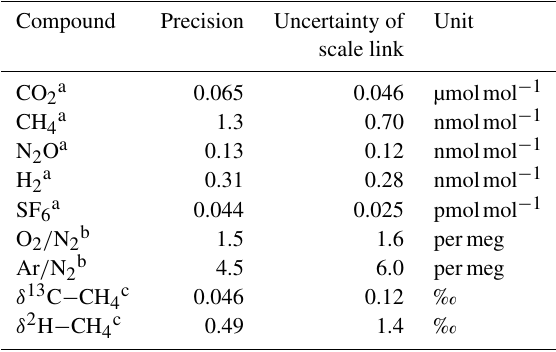
Table 1. Average measurement uncertainties of the flasks collected during CoMet 1.0. All values given with coverage probability of 0.68. A correction factor based on Student’s t distribution was ap- plied to account for low population size, following the Guide to the Expression of Uncertainty in Measurement (JCGM,